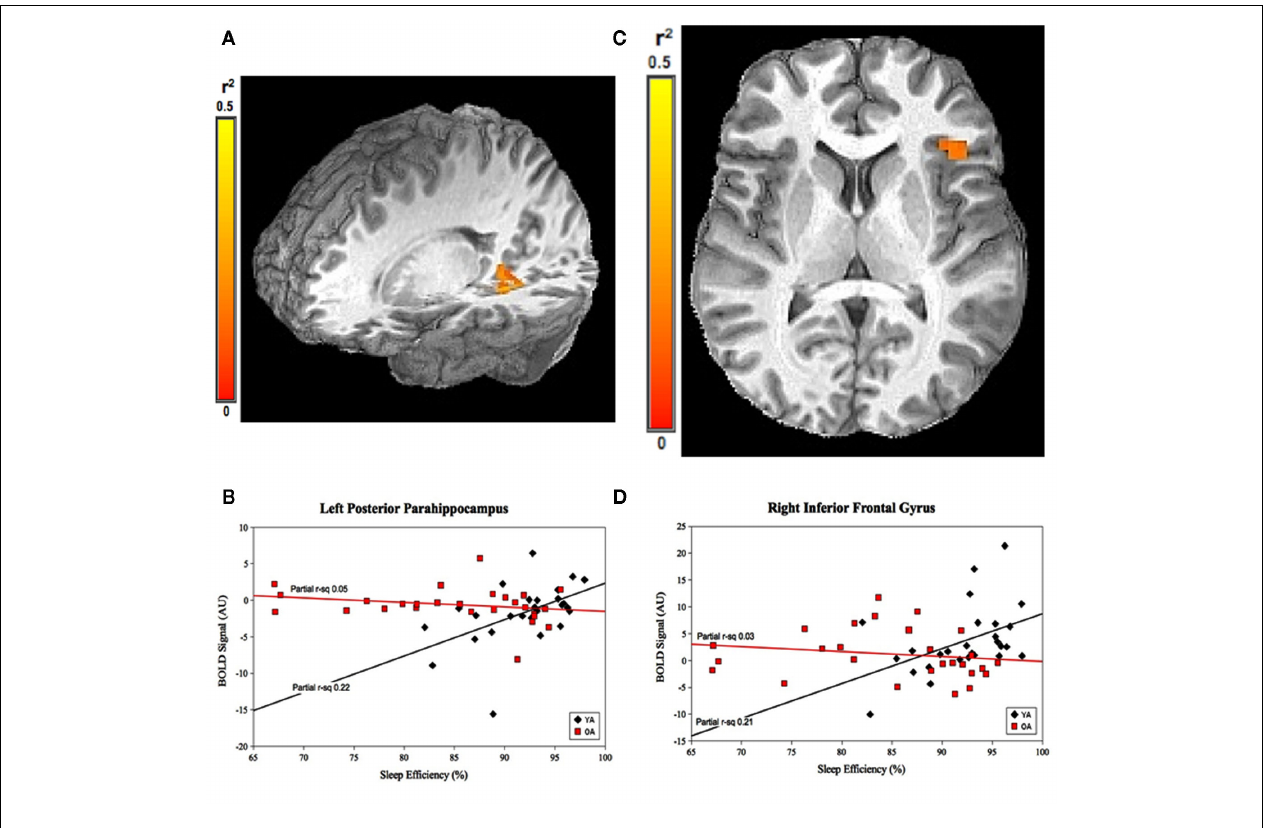
FIGURE 2 | Group-by-prior sleep interaction for SE. Left posterior parahippocampal gyrus and right inferior frontal gyrus regions showing group-by-SE interaction. (A,C) Color scale represents r 2 associated with the interaction term in the statistical model (max r 2 = 0.5). (B,D) Graphs